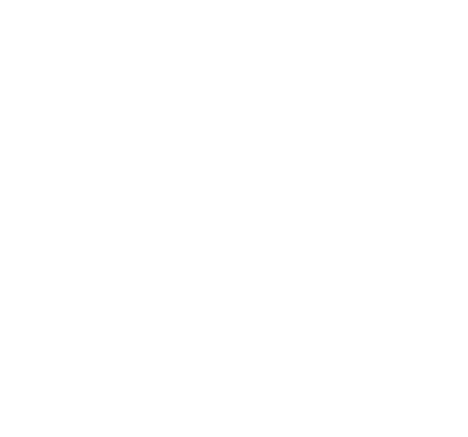
Figure 8. Sensing architecture block diagram of sensor and